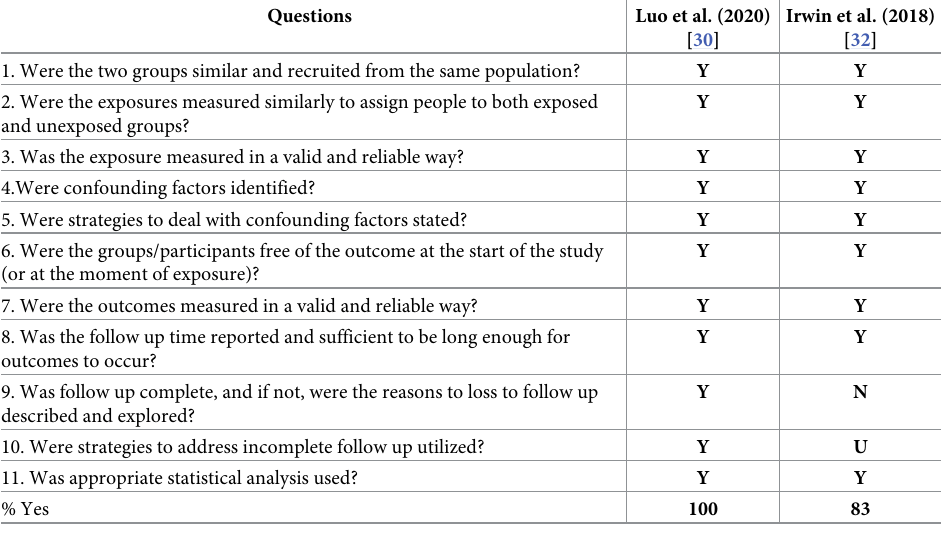
Table 3. Quality assessment of cohort